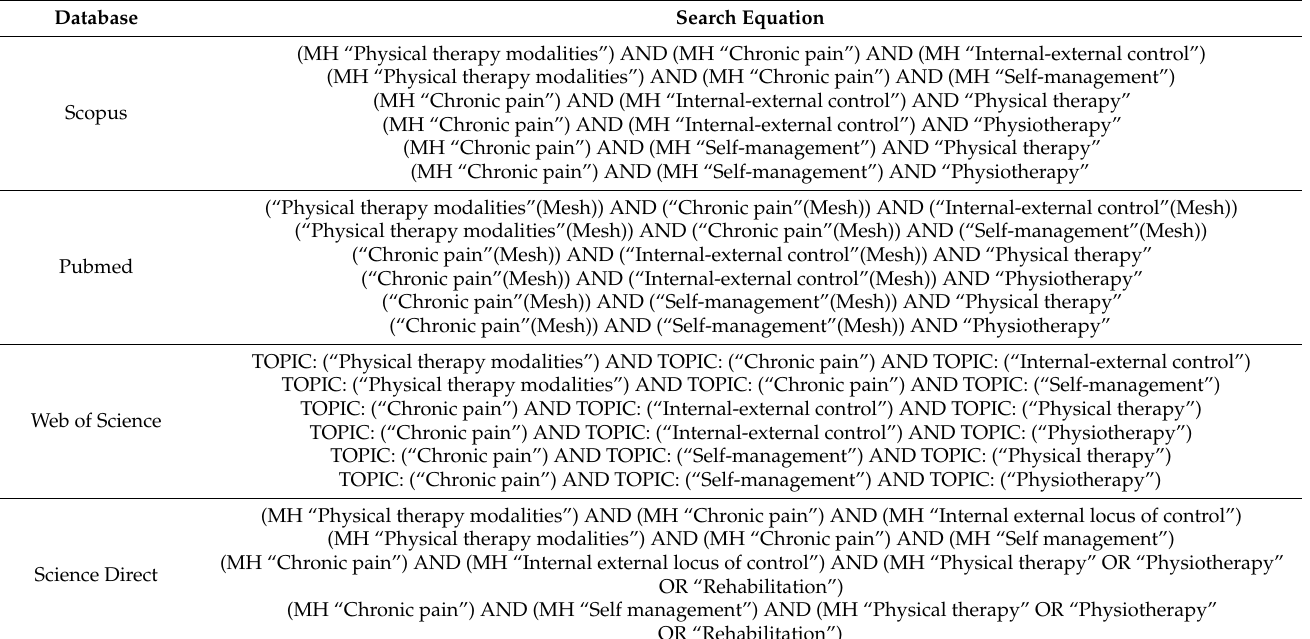
Table 1. Search equations used. MH—medical